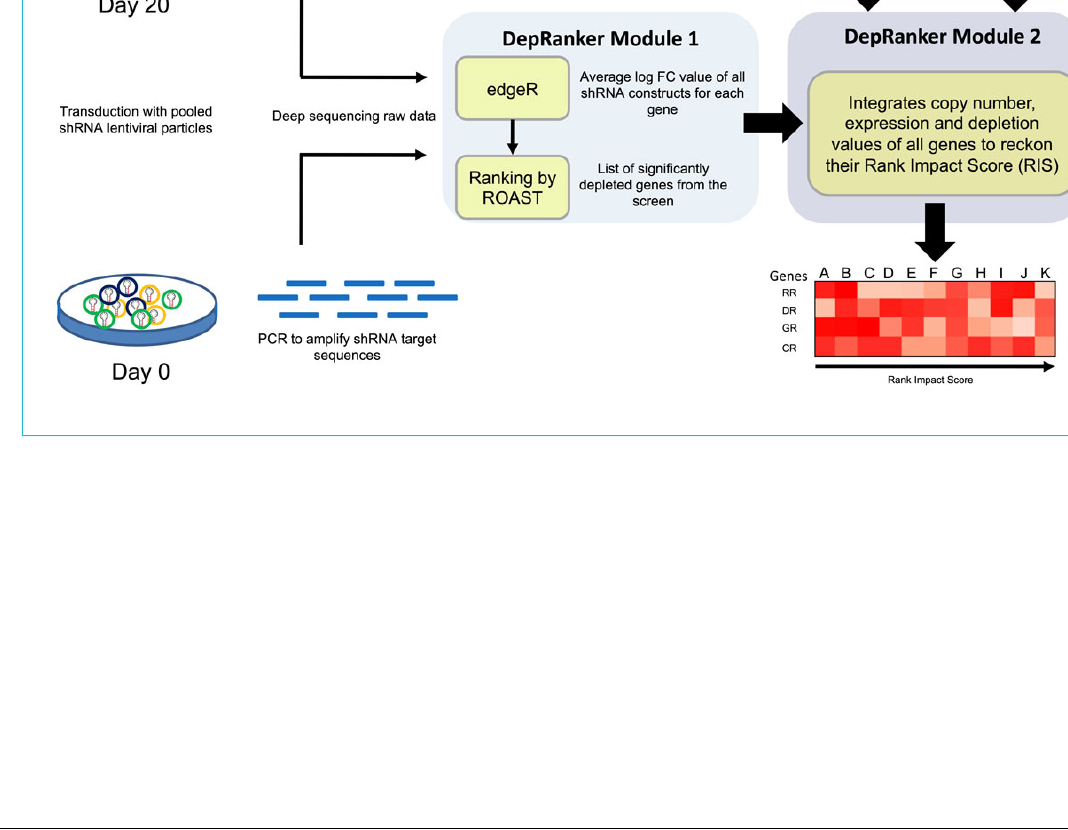
Table S5: The Rank Impact Scores (RIS) and weightings